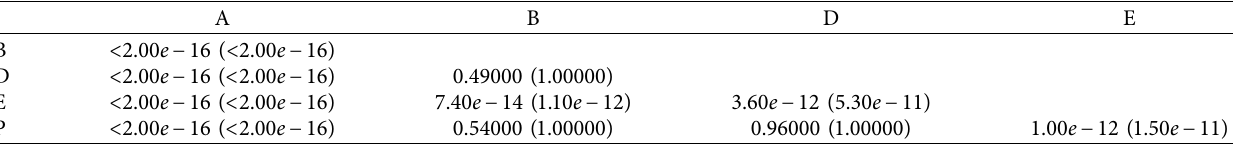
Table 10: In L-Space, for Auckland network, pI � 0.05, pR � 0.0025, and T � 150, p -value of the Wilcoxon rank sum test (resultant p -value per Bonferroni correction is indicated in